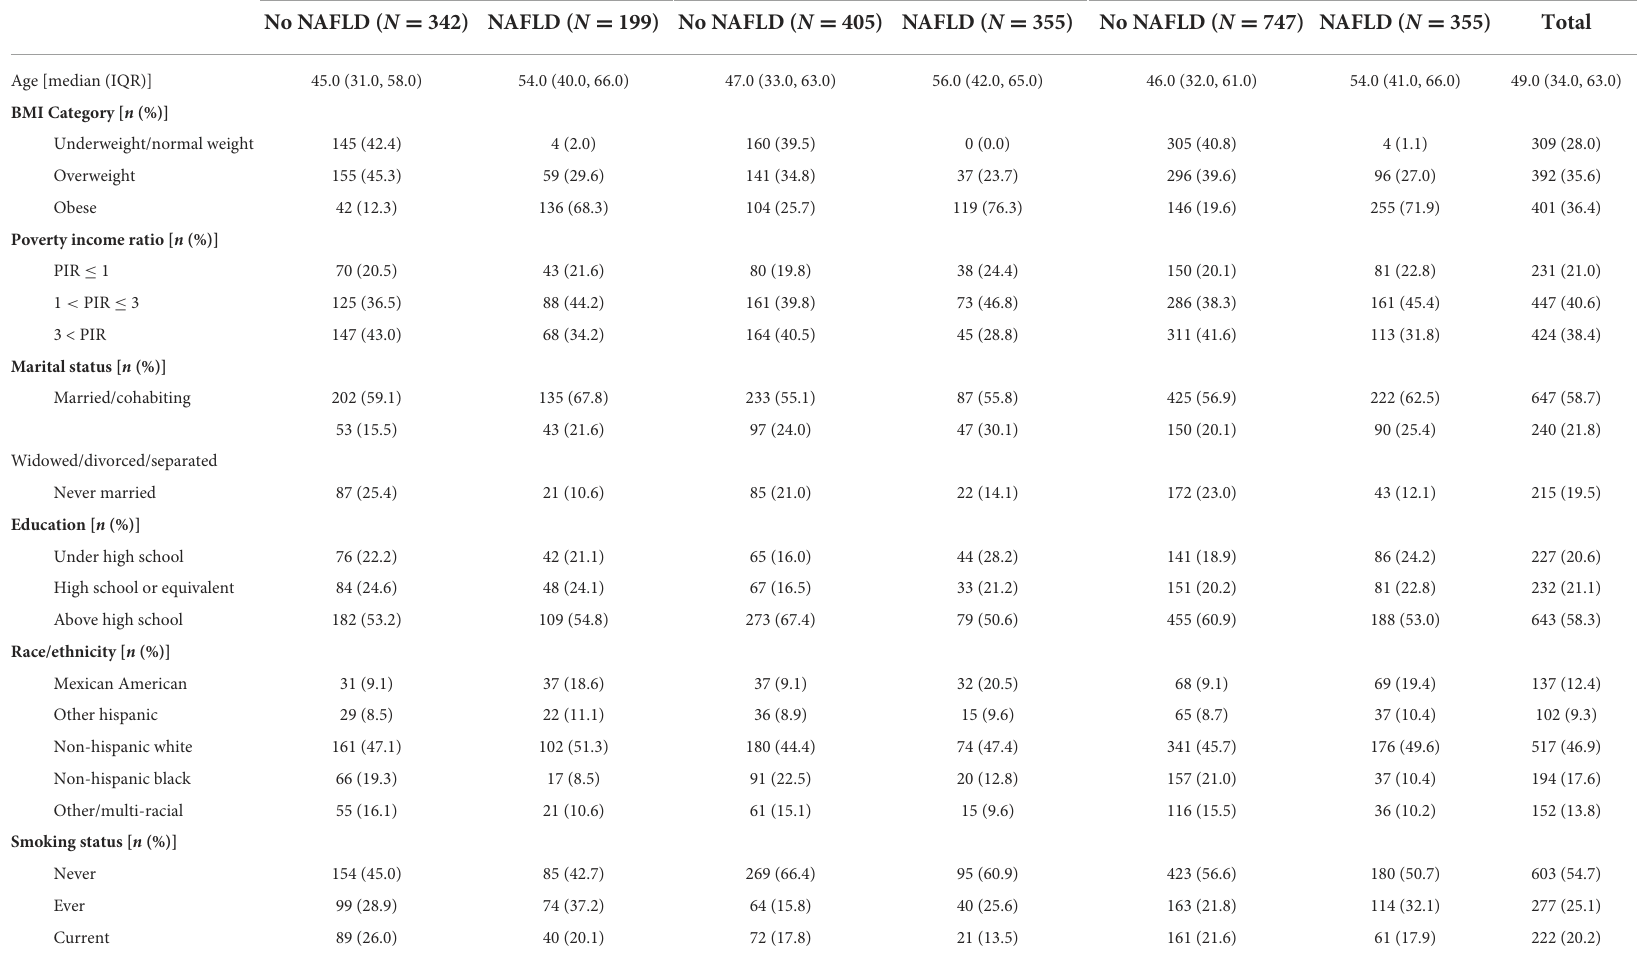
TABLE 1 Baseline characteristics of the 1,102